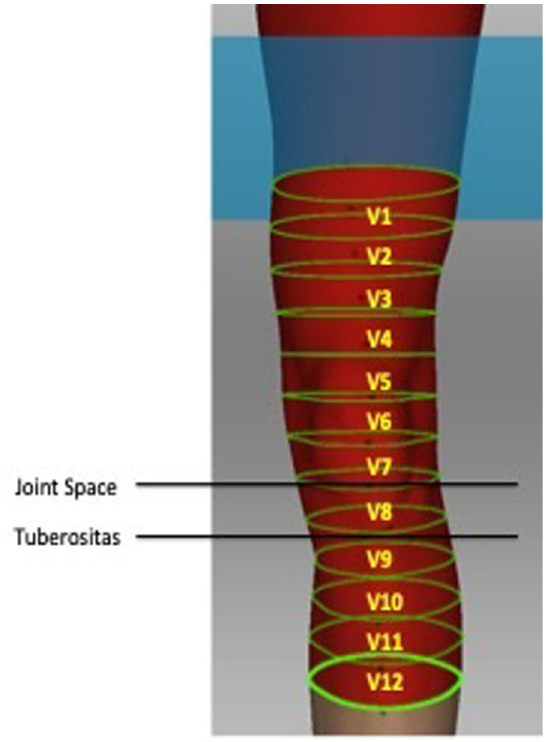
Fig 1. Volumes. 3D scanning of the knee indicating the measured volumes 20 cm proximal and 10 cm distal from the tibial tuberosity (starting point). The volumes were subdivided into segments of 2.5 cm.